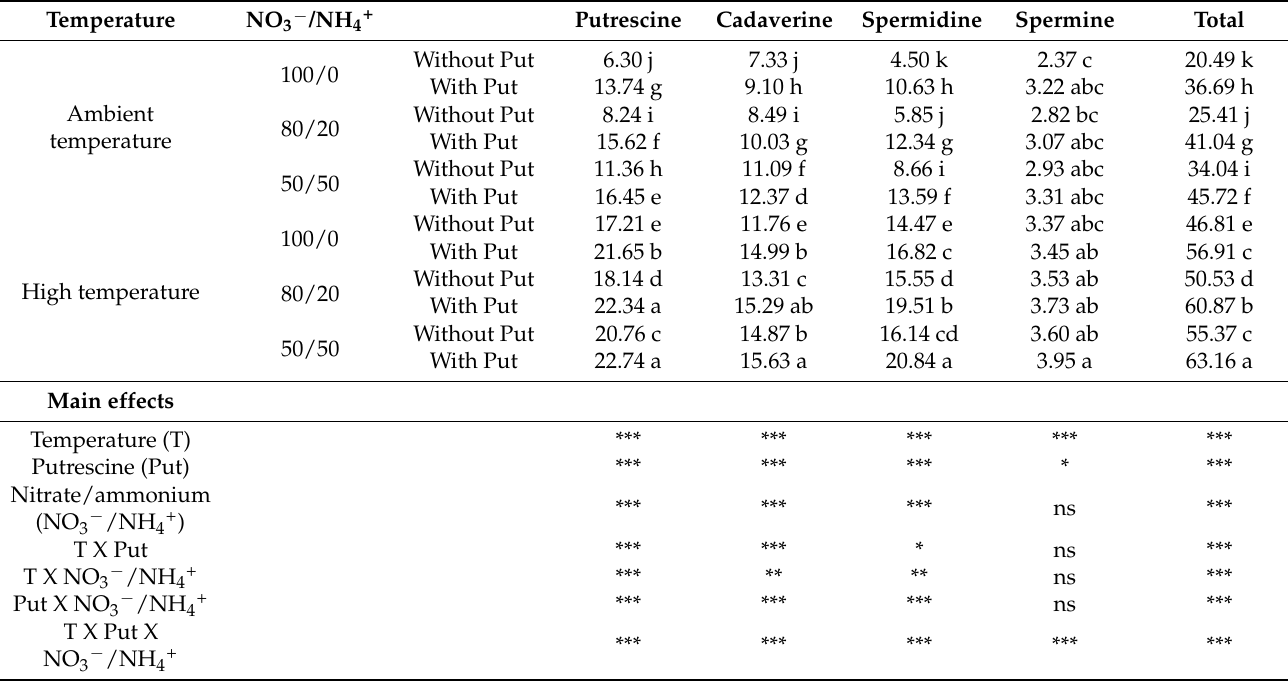
Table 4. Effect of the foliar application of putrescine on the concentrations of polyamines (nmols g − 1 ) in outer leaves of the cauliflower cv. Moonshine at different NO 3 − /NH 4+ ratios and temperatures.